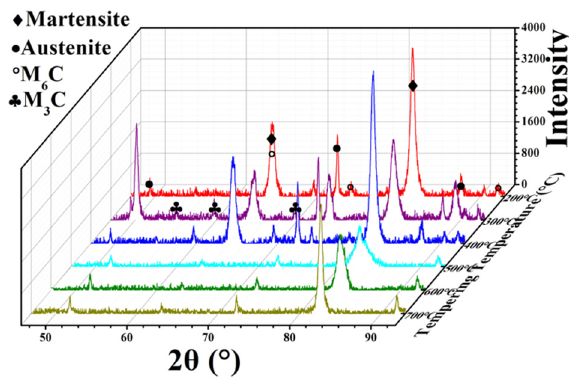
Figure 3. X-ray diffraction (XRD) patterns of M42 HSS after Different Tempering Treatments.